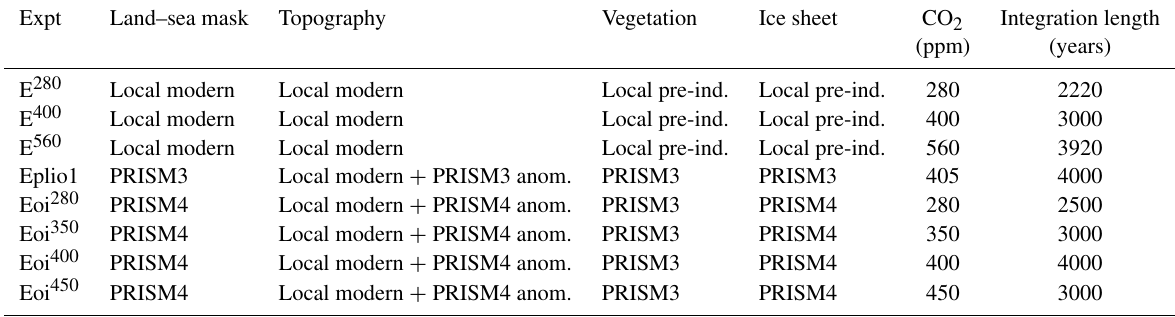
Table 1. Boundary conditions, CO 2 levels and model integration length for each experiment in the present study.